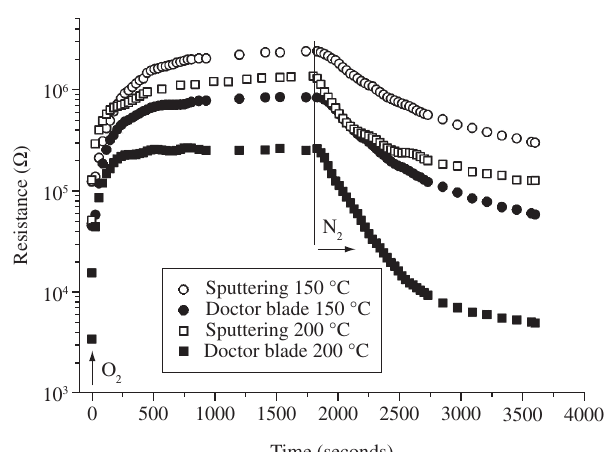
Figure 4. Changes in the electrical resistance with time for doctor-bladed and sputtered samples kept in nitrogen, exposed to oxygen and back to nitrogen atmosphere at 150 and 200 °C.